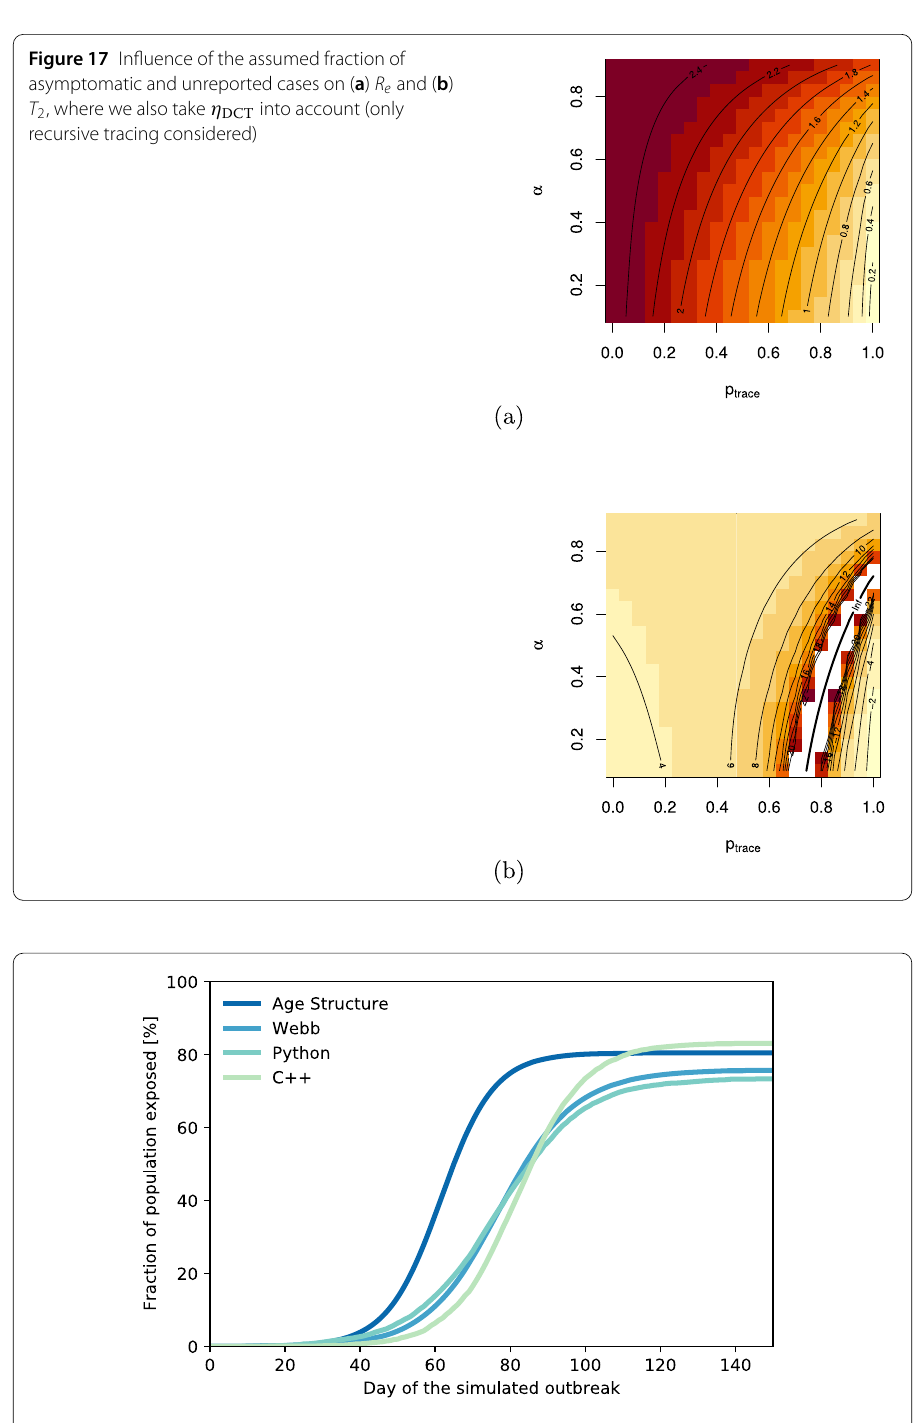
Figure 18 The cumulative number of exposed people from the four models and for the settings from Tab. 4